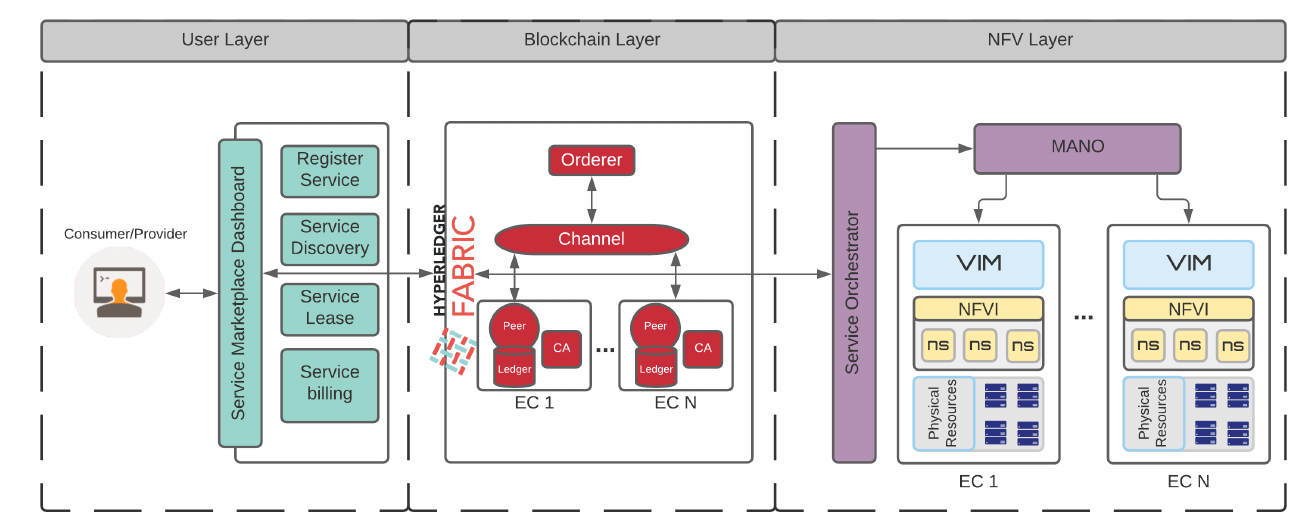
Figure 1. Network Service Management